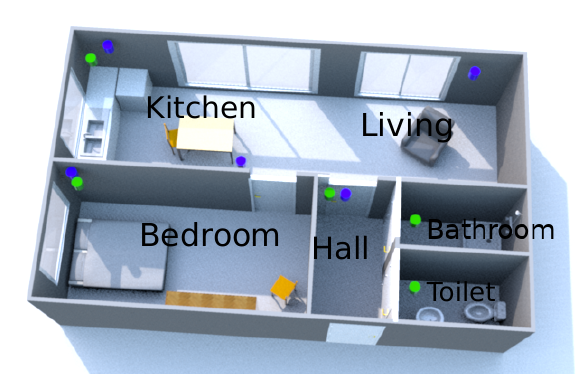
Figure 2. Simplified overview of location 1. The locations of the five motion sensors (green cylinders) and cameras (purple cylinders) are